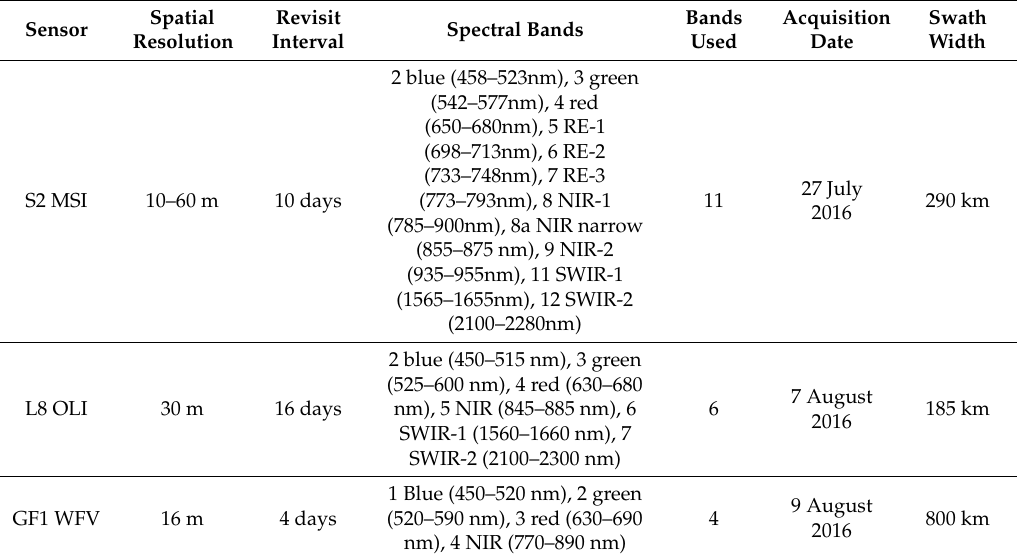
Table 1. Sensor characteristics of Sentinel-2A Multispectral Instrument (S2 MSI), Landsat-8 Operational bands not